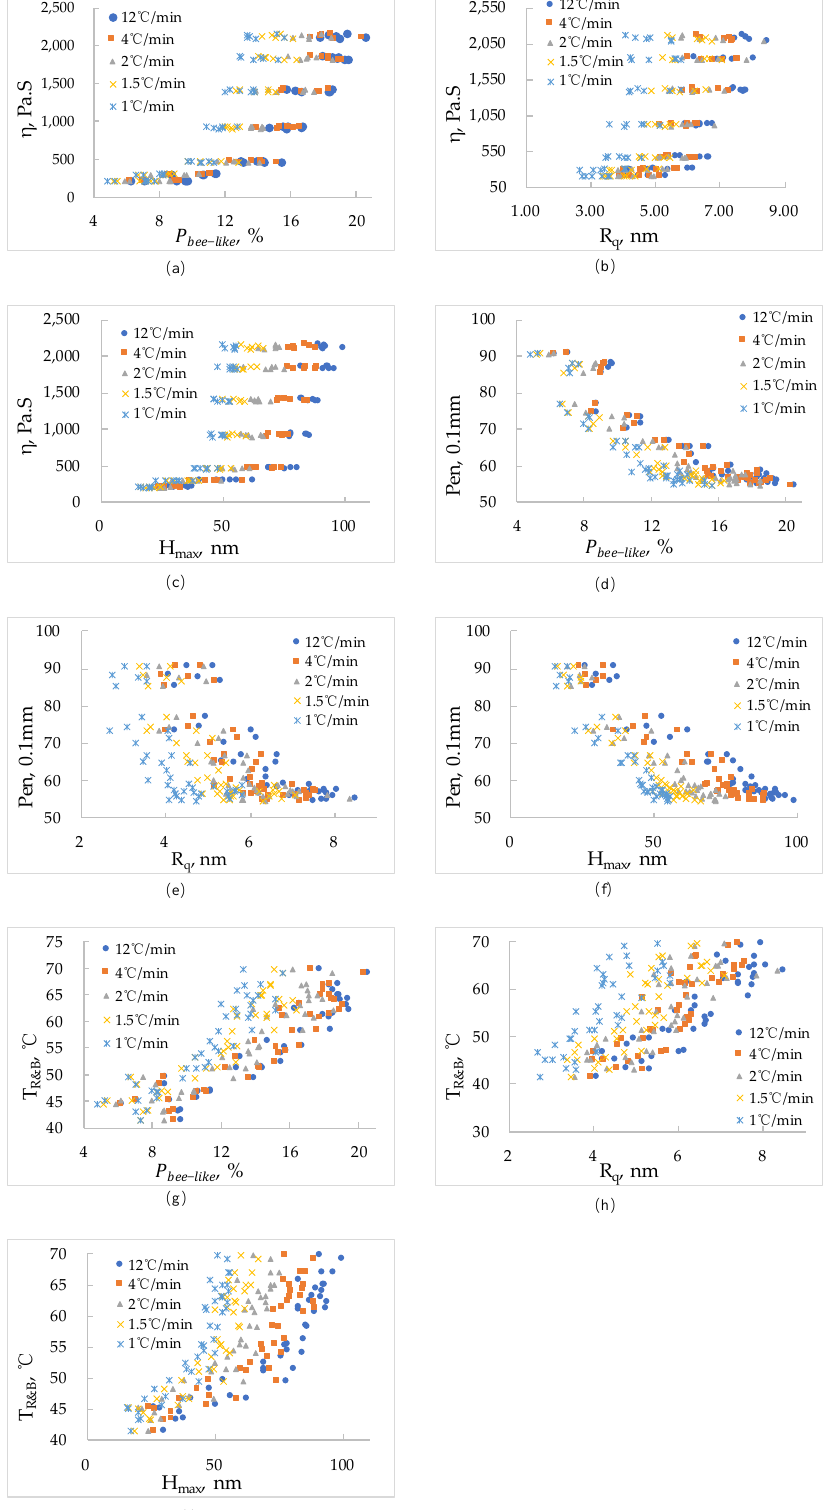
Figure 8. Relationship between asphalt nano-parameters and technical indexes. ( a ) η and P bee − like ; ( b ) η and R q ; ( c ) η and H max ; ( d ) Pen and P bee − like ; ( e ) Pen and R q ; ( f ) Pen and H max ; ( g ) T R&B and P bee − like ; ( h ) T R&B and R q ; ( i ) T R&B and H max